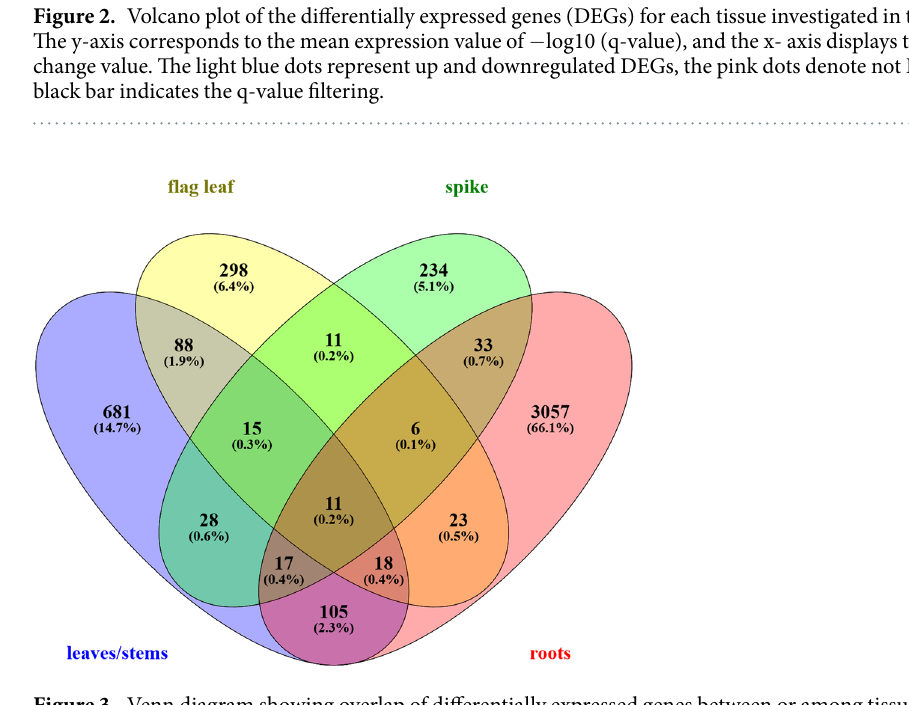
Figure 3. Venn diagram showing overlap of differentially expressed genes between or among tissues. Root, leaves/stems, flag leaf and spike RNA libraries were obtained from durum wheat, Svevo cultivar, grown in nitrogen starvation (0 mM nitrogen), or in standard (2 mM nitrogen)